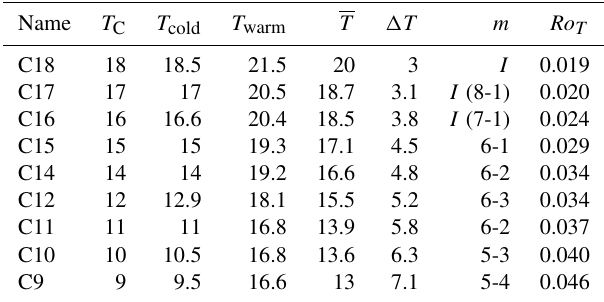
Figure 1. Schematic drawing of the experimental apparatus. The water in the inner cylinder (in blue) is cooled using a thermostat. Heating wires heat the water in the outer ring (in red). The water in the inner gap ( b − a ) is subjected to a radial differential temperature inferred by the insulating walls. The tank rotates anticlockwise at a constant rotation rate (cid:127) . The surface temperature of the fluid in the gap is measured by an infrared camera aligned with the axis of rotation.